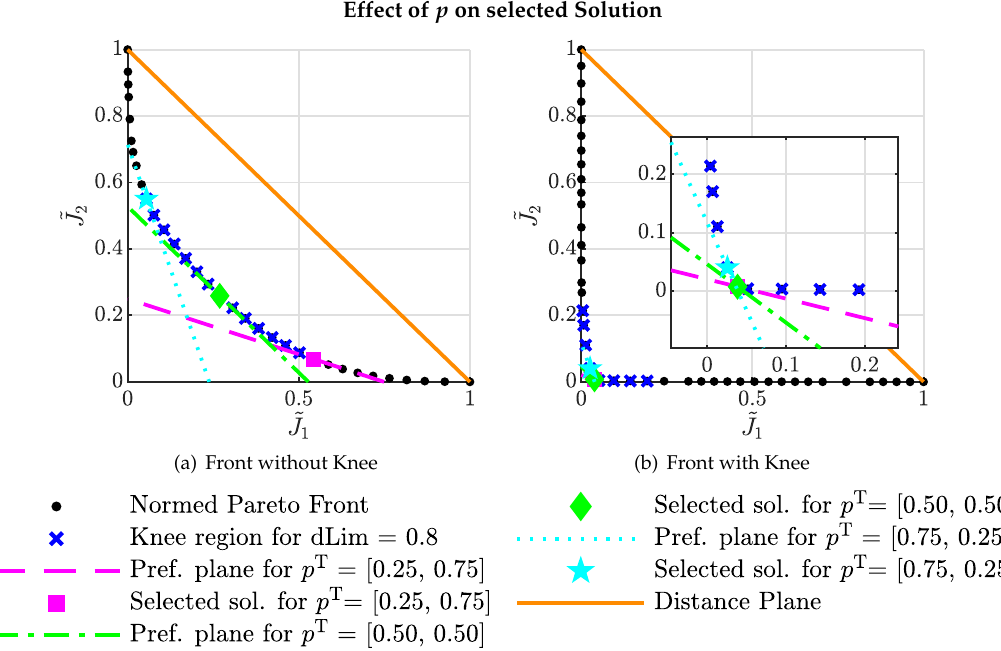
Figure 4. Exemplary preference planes (12) for the Pareto fronts from Figure 2 and r lim = 0.8. Note that for the front without a knee in ( a ), the different preferences lead to solutions far apart from each other. For the front with a knee in ( b ), two of the three preferences choose the knee itself. Even for p (cid:124) = [ 0.75,0.25 ] , the selected solution is close to the knee point, despite the large knee region (with solutions a human decision maker would not consider